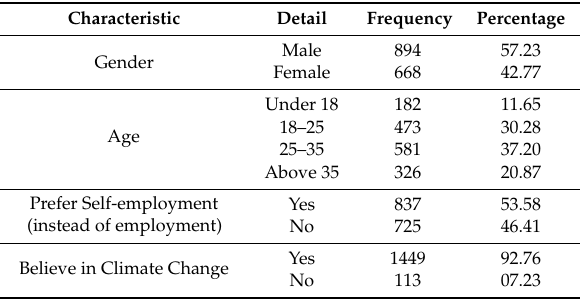
Table 2. Surveyed sample